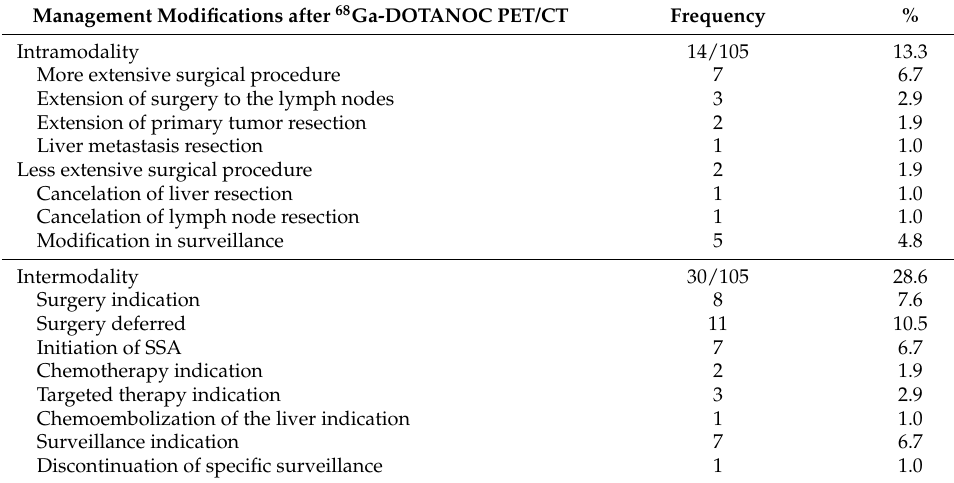
Table 6. Impact of 68Ga-DOTANOC on the clinical